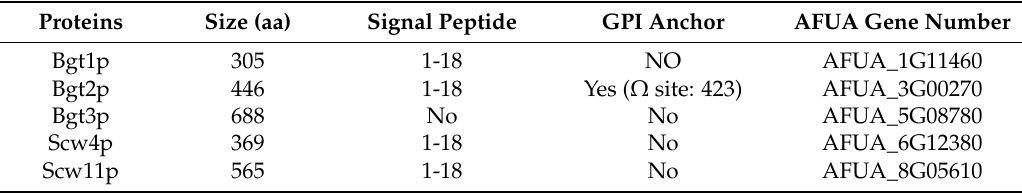
Table 1. Characteristics and size of the GH17 proteins of A. fumigatus